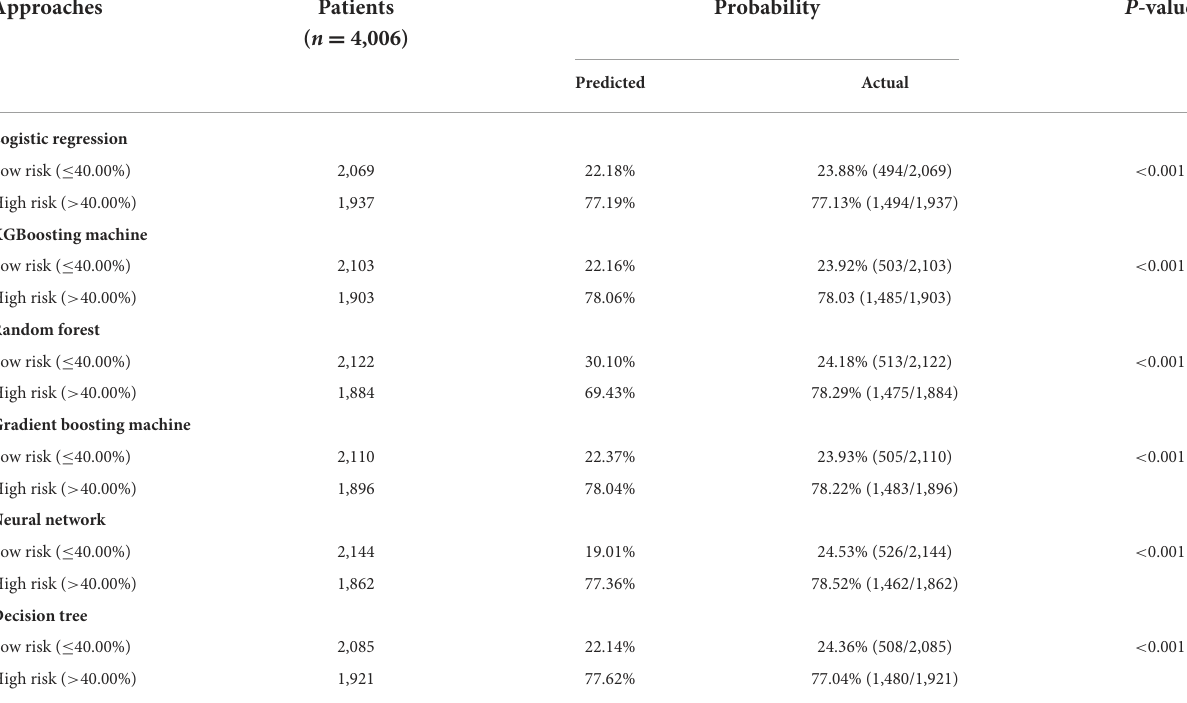
TABLE 4 Risk stratification based on the optimal cut-off value in the models.